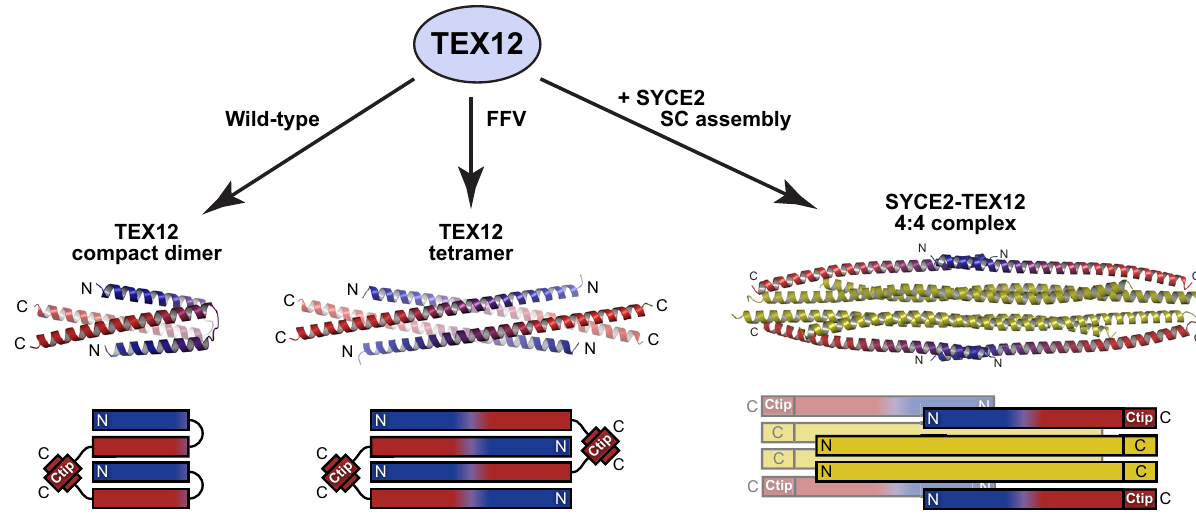
Fig. 9 Structural diversity of TEX12 assemblies. TEX12 adopts a compact dimer structure that undergoes conformational change into an extended tetramer upon FFV mutation. These structures share a common fold in which TEX12 chains interact in a four-helical bundle, stabilised by coiled-coil interactions between their Ctip sites. TEX12 chains adopt a helix – loop – helix conformation within the dimer, and open into linear helices within the tetramer. TEX12 also interacts with SYCE2 to form a 4:4 complex that assembles into fi bres within the SC. Within this complex, TEX12 chains adopt linear conformations and orient Ctip sites to mediate assembly by forming four-helical structures with SYCE2 ’ s C-termini. The TEX12 compact dimer, TEX12 tetramer and SYCE2-TEX12 4:4 complex models are shown along with their schematics; TEX12 chains are coloured blue to red in an N- to C-terminal direction and SYCE2 chains are shown in